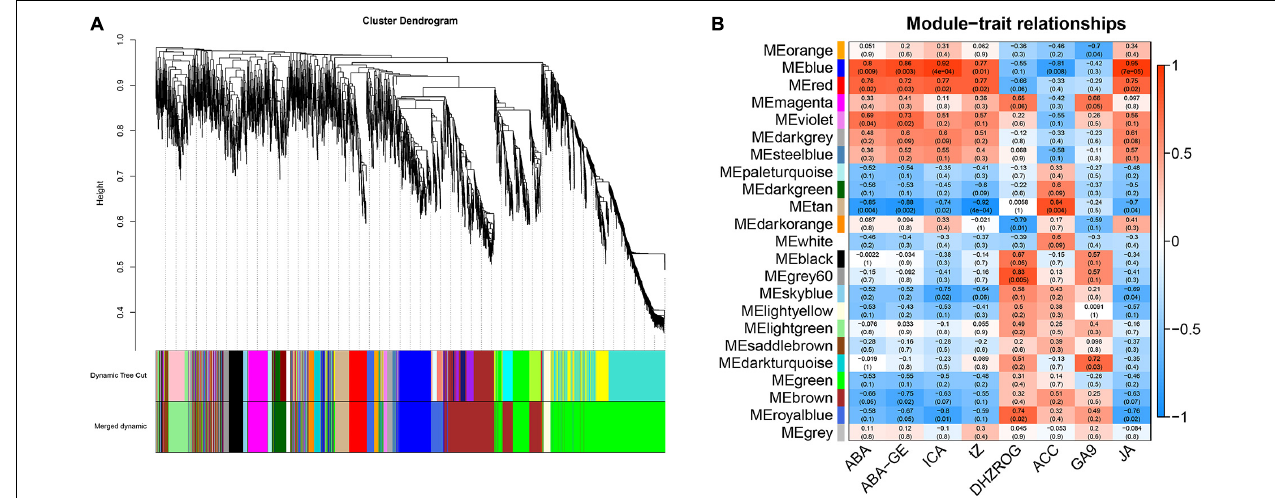
FIGURE 4 | Weighted gene co-expression network analysis of the genes in mature leaves under 3 light qualities. (A) Hierarchical clustering tree representing co-expression modules identified by WGCNA. The main branches marked with different colors make up 23 modules. (B) WGCNA analysis between DEGs and phytohormones under 3 light qualities. Each row represents a module. The color and number of each cell represents the correlation coefficient between modules and phytohormones.